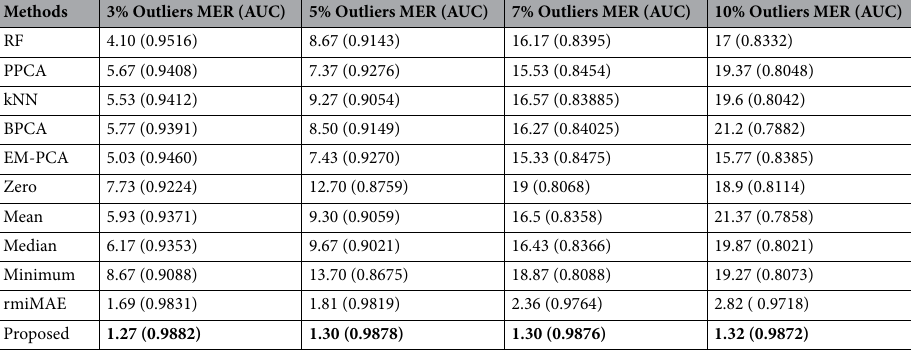
Table 2. Average misclassification error rate(MER) and area under the receiver operating characteristic curve (AUC) for two class simulated data with 5% missing values and different rates of outliers. Bold indicates the lower MER and Higher AUC throughout the column.